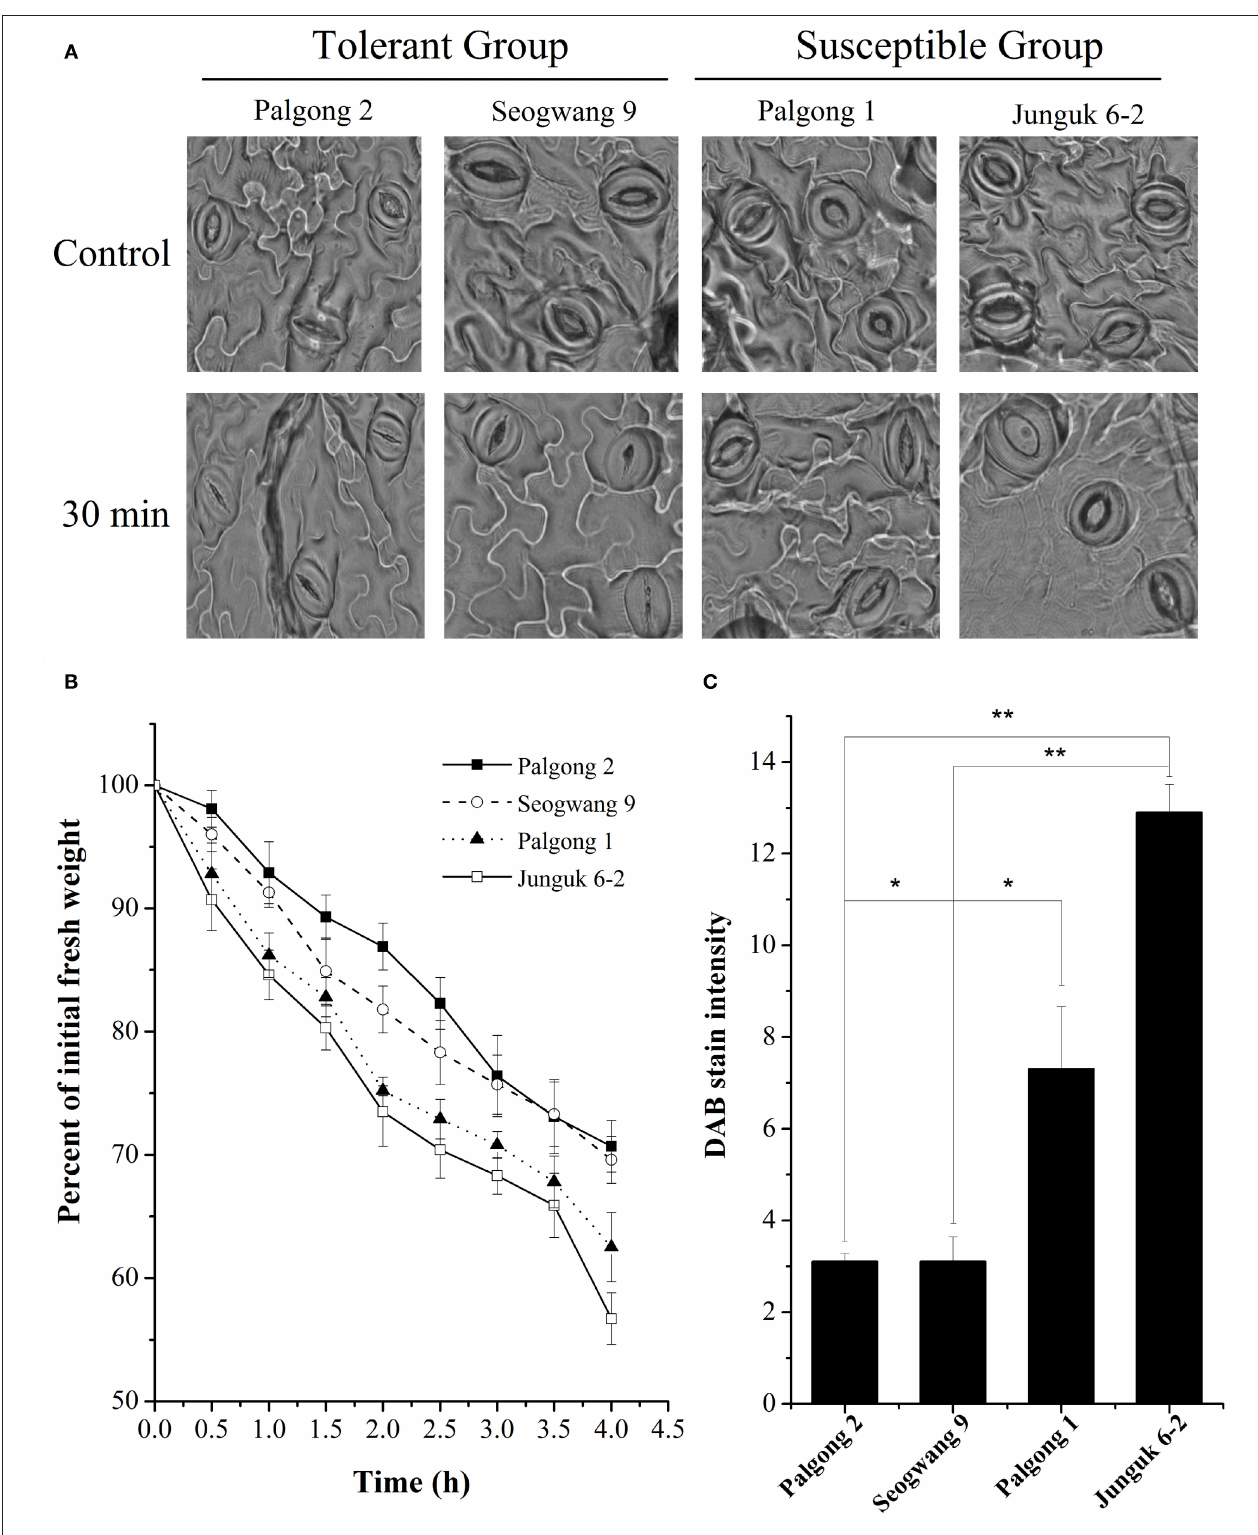
FIGURE 2 | Stomatal conductance in response to dehydration. Scanning electron micrographs showed the stomatal aperture of the drought-tolerant and susceptible plants before and after 30min of dehydration stress (A) . Percent loss in fresh weight after 4h of dehydration stress (B) . Quantification of hydrogen peroxide (H 2 O 2 ) released after 30min of dehydration stress measured by diaminobenzidine (DAB) staining (C) . Each data point shows the mean of at least three replicates. Error bars represent SD. Significant differences at P < 0.05 are indicated by *. Significant differences at P < 0.01 are indicated by **.